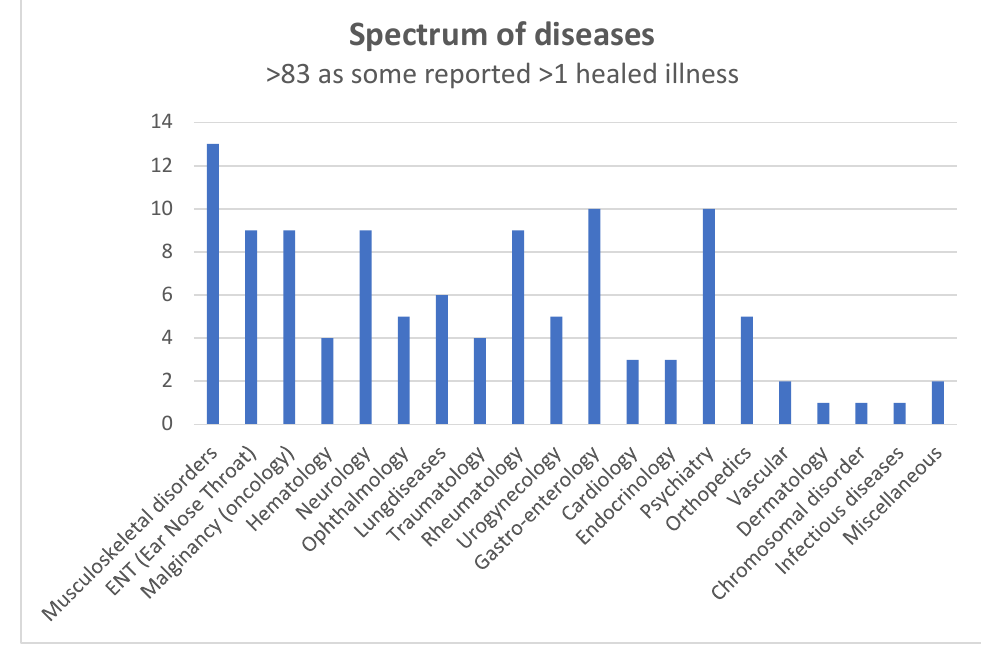
Figure 1. Spectrum of diseases reported. The assessment team evaluated 27 cases in the period between 2016 and 2020. Table 6. 27 evaluations by the medical assessment team; availability of data until 2021. E = expectancy NE = no expectancy LE = low expectancy ME = moderate expectancy HE = high expectancy N/A = not applicable (e.g., comatose); Age = age category at moment of healing. Duration of healing: time period from healing until 2021 or until relapse/death.